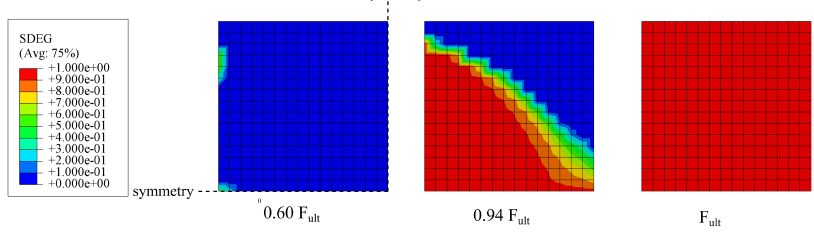
Figure 21. Results of the splitting test simulation—evolution of the degradation parameter in the